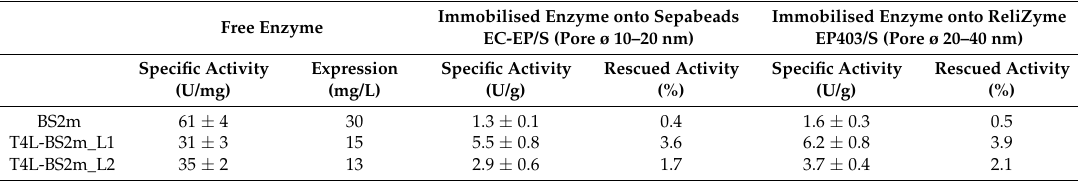
Table 2. Comparison of specific activities and expression levels of the original Bacillus subtilis esterase (BS2m) and the two chimeric proteins in the free enzyme form. Specific activities of the resin following immobilisation of enzymes (5 mg enzyme /g resin ), and percentage of residual activity after immobilisation (2 h, room temperature, in 50 mM phosphate buffer pH 8) with respect to the free